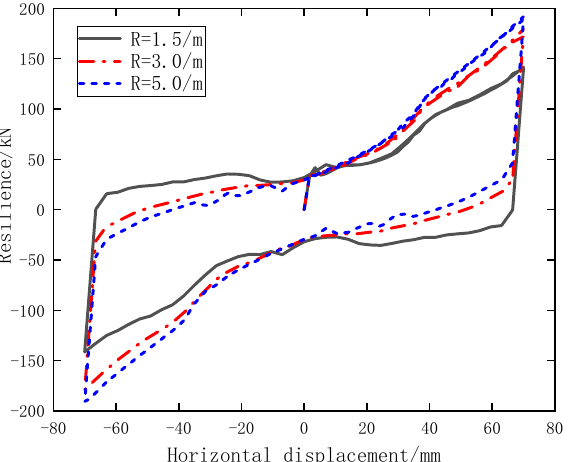
Figure 12. Hysteresis curves of SMA-negative stiffness hyperboloid shock absorber with different surface radii.